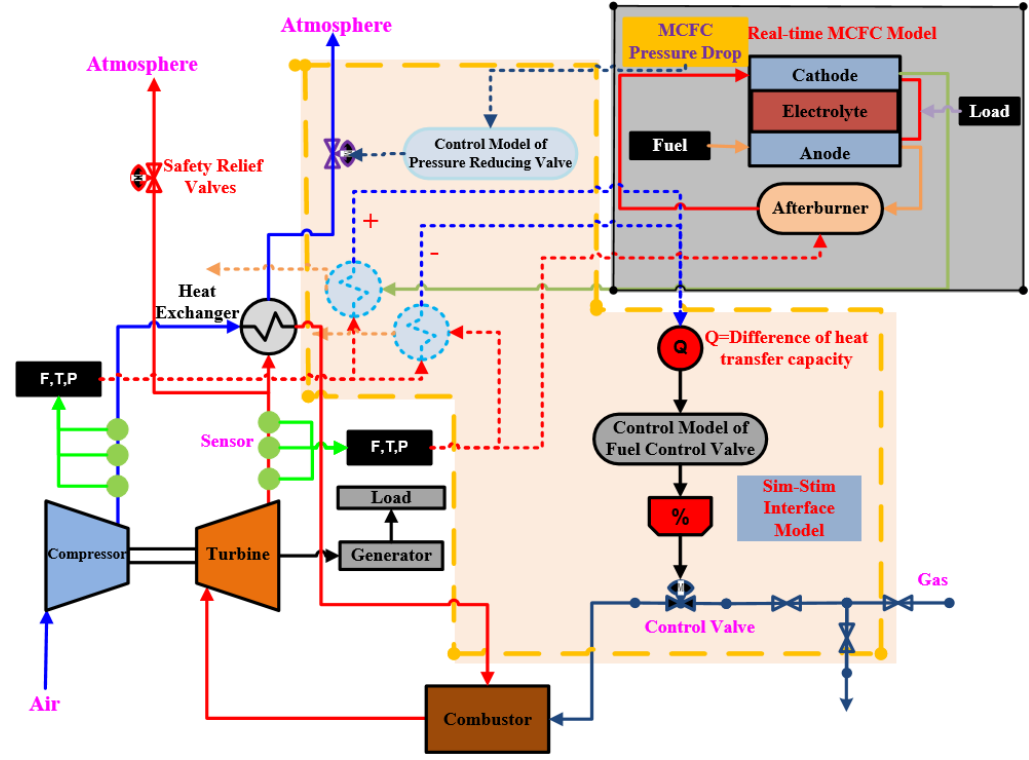
Figure 2. Schematic diagram of MCFC-MGT hybrid power system based on the Sim–Stim interface model.